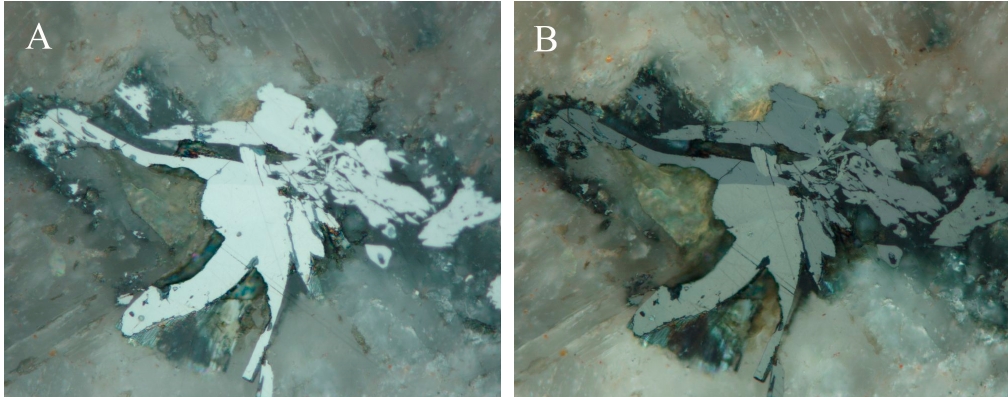
Figure 45. Prismatic p ř íbramite crystals embedded in calcite. Reflected light, ( A ) one polarizer, ( B ) partly-crossed polarizers. FOV 210 μ m. P ř íbram, a dump of shaft 16. Photo by P. Škácha.